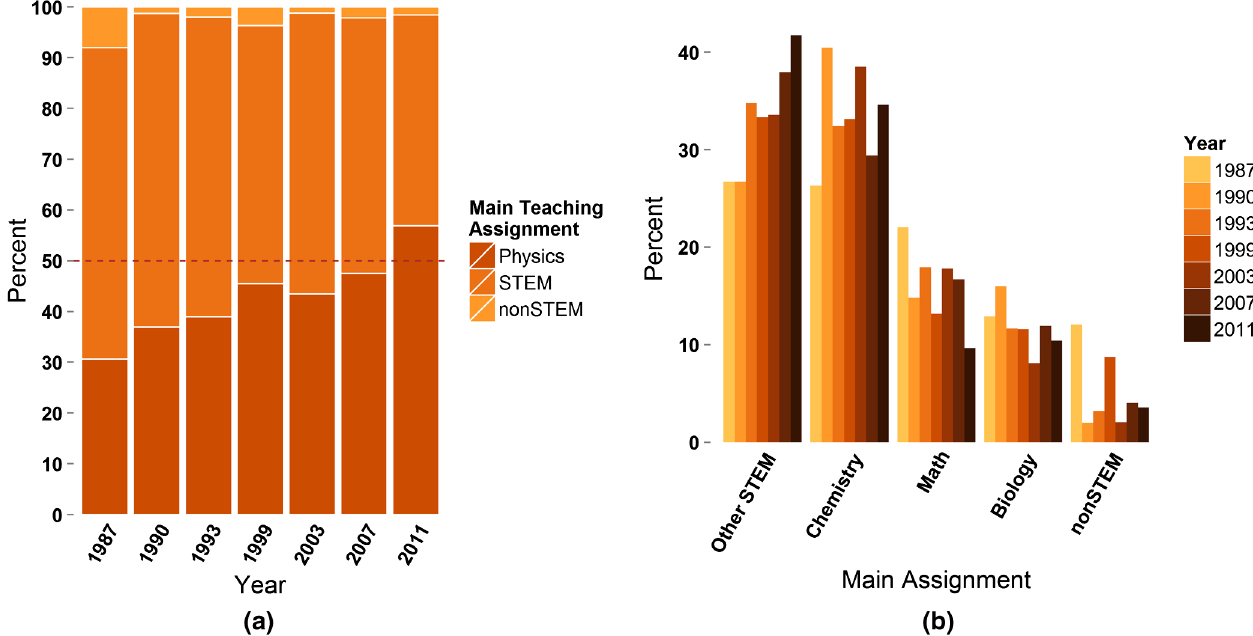
FIG. 3. (a) Main teaching assignments for all physics teachers between 1987 and 2011 (standard error ≤ 4 . 38 %). (b) Top five nonphysics main assignments for each survey year (standard error ≤ 6 . 63